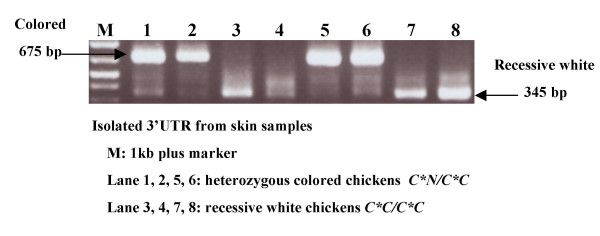
Shorter 3'UTR are isolated by RACE from recessive white skin samples. The major 3'UTR isolated in the recessive white was 345 bp and the major 3'UTR isolated in the heterozygous colored chicken was 675 bp.